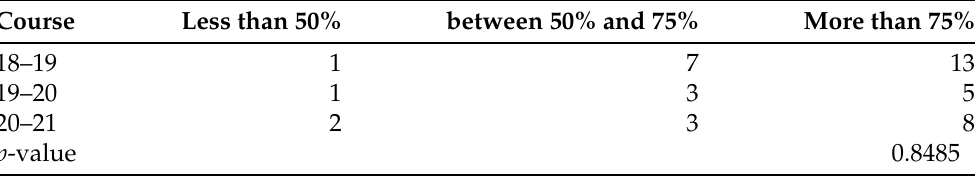
Table 18. Attendance to seminars frequency table and p -value applying Fischer’s exact test